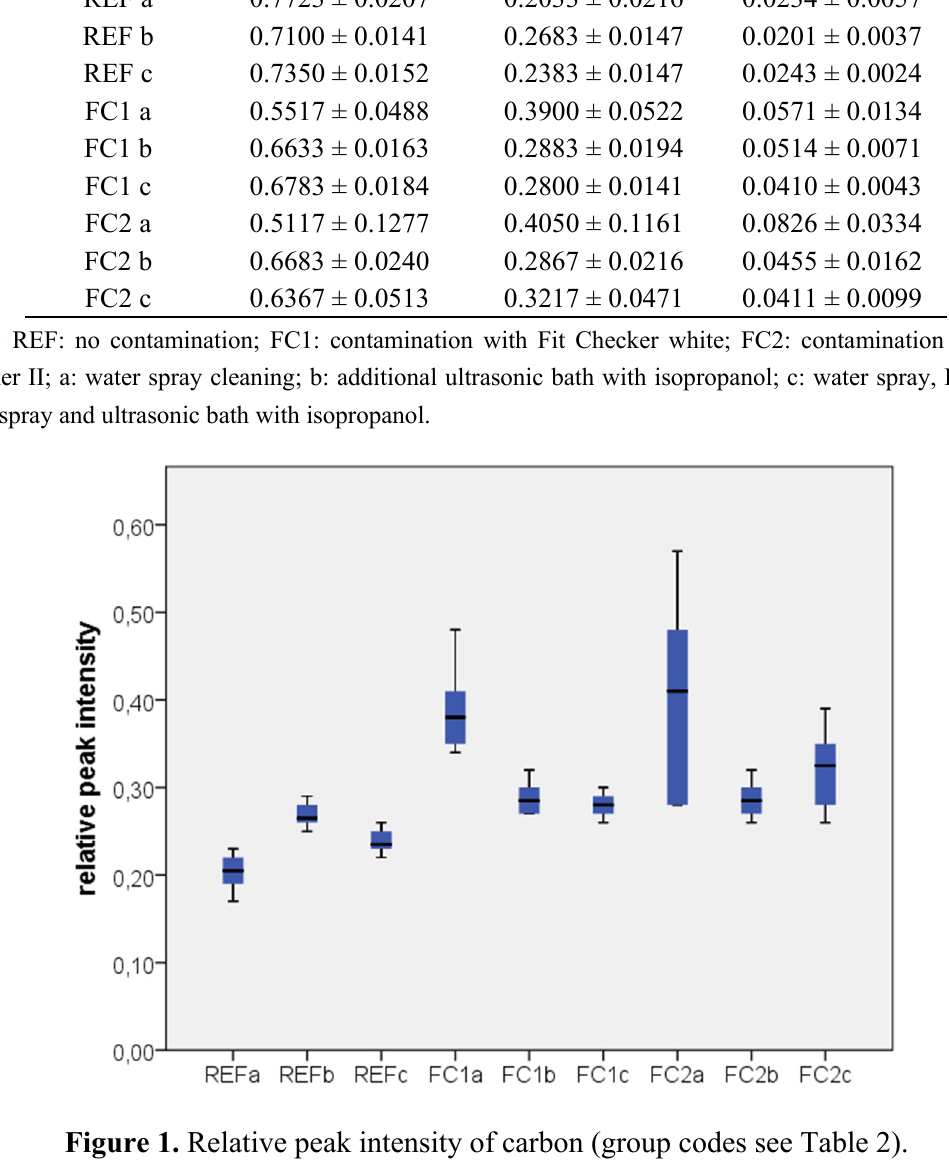
Figure 1. Relative peak intensity of carbon (group codes see Table